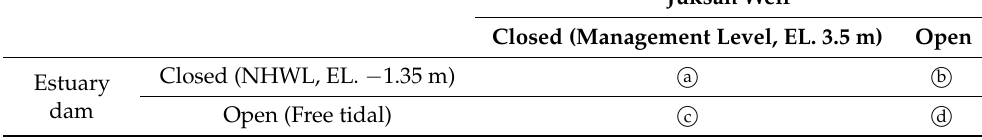
Table 4. Scenarios for the operation of the Juksan Weir and estuary dam. Scenario a (cid:13) stands for the closure of both the Juksan Weir and estuary dam, scenario b (cid:13) stands for the opening of the Juksan Weir alone, scenario c (cid:13) stands for the opening of the estauary dam only, and scenario d (cid:13) stands for the opening of both the Juksan Weir and estuary